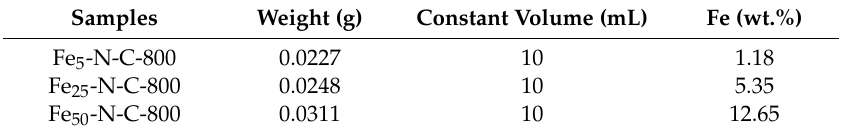
Figure 2. Characterizations of the Fe 25 -N-C-800 catalyst. ( a , b ) SEM images at di ff erent magnifications; ( b–d ) TEM images at di ff erent magnifications; ( e–h ) elemental-mapping images of high-angle annular dark-field (HAADF), iron, carbon, and nitrogen. Table 1. Elemental information of synthesized Fe X -N-C-800, analyzed by inductively coupled plasma (ICP).